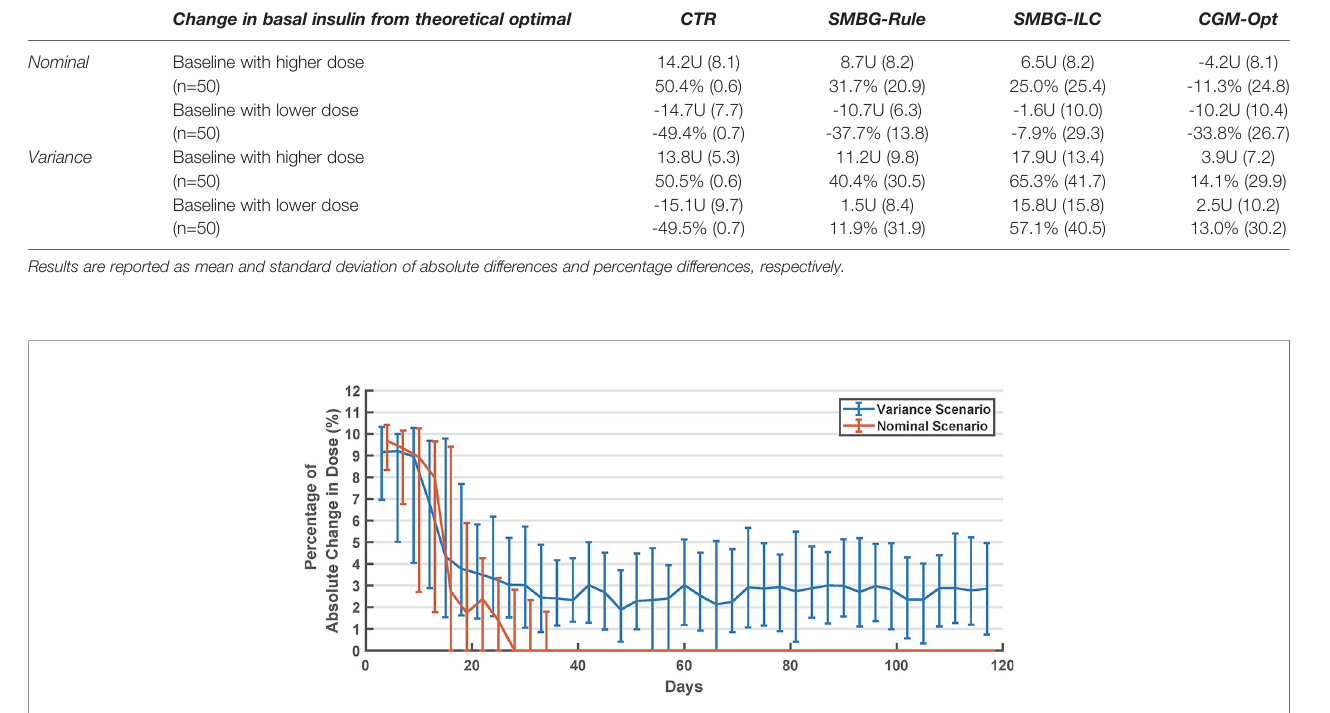
FIGURE 3 | Summary of long-acting dose changes in titration days (every 3 days). Values are shown as median and interquartile range.